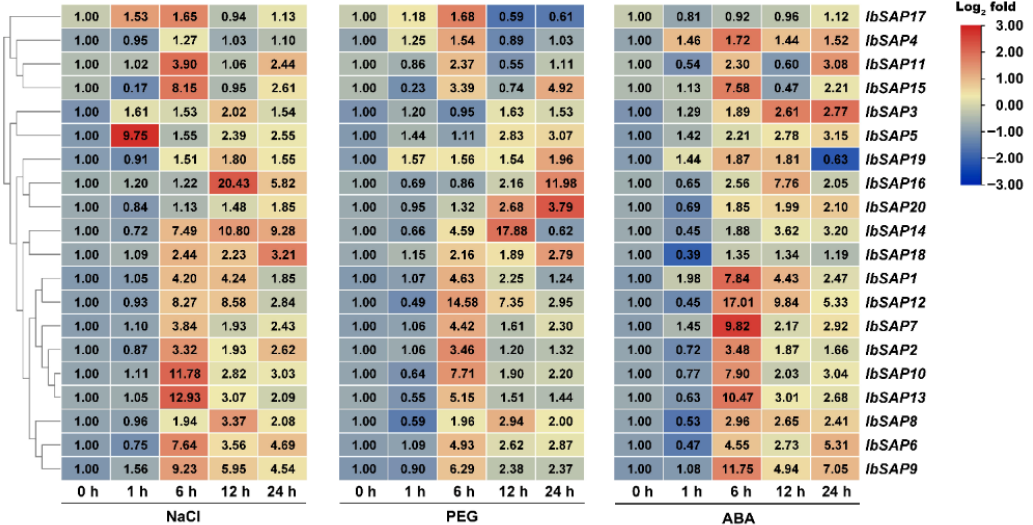
Figure 6. Expression patterns of IbSAP genes in response to salinity, drought, and ABA treatment. Sweetpotato shoots were treated with 100 mmol·L − 1 NaCl, 15% polyethylene glycol (PEG), or 10 μ mol·L − 1 ABA, and the mRNA levels were quantified by RT-qPCR and normalized using the 2 −ΔΔ Ct method. IbARF (JX177359) was used as an internal reference.